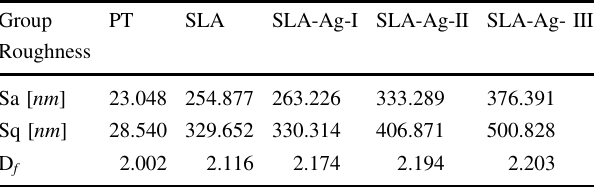
Table 1 The Sa and Sq values of different Ti surfaces